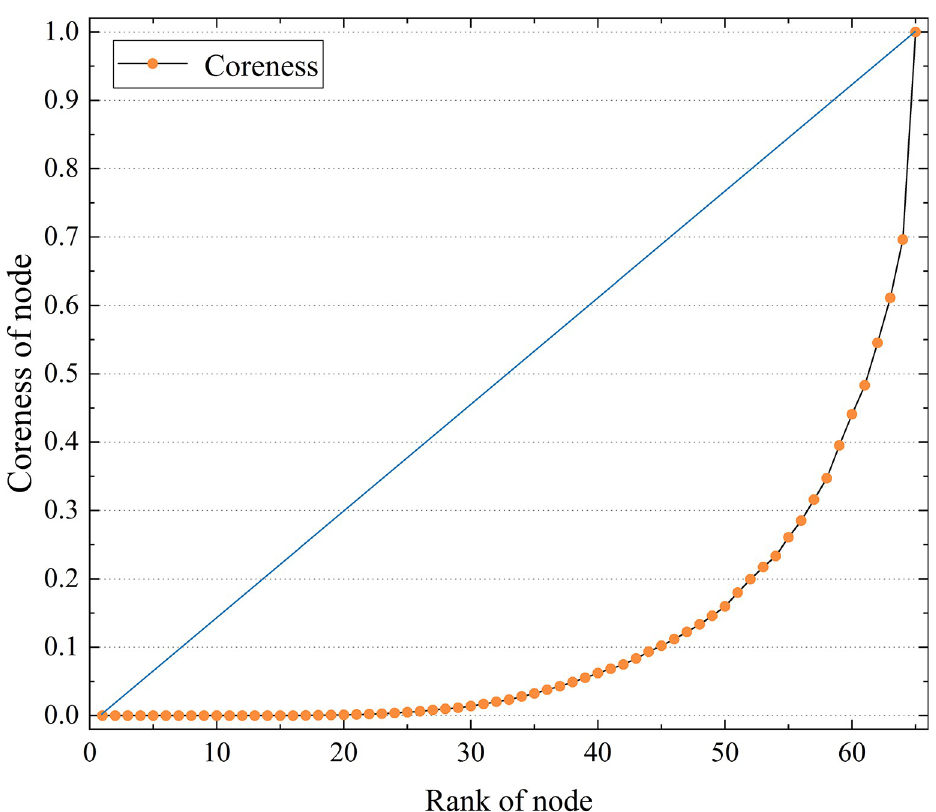
Fig 3. The relationship between coreness and rank of the countries in BRI trade